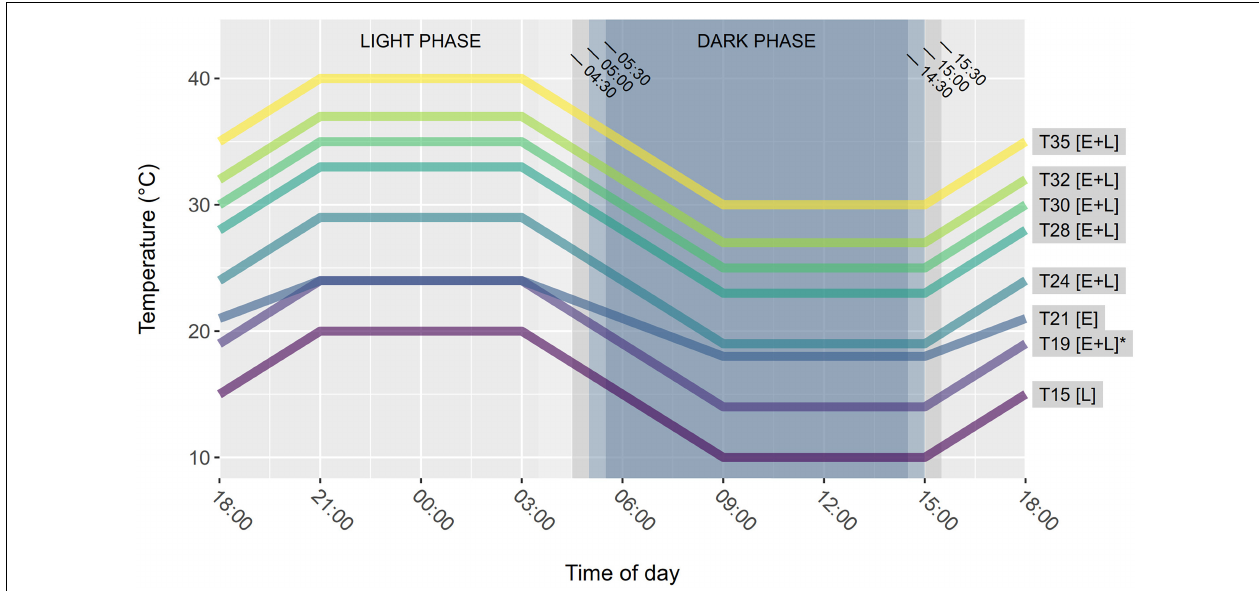
FIGURE 2 | Thermal fluctuations and photoperiod used in each rearing treatment. Transitions between light and dark phases were progressive (30 min with 1/3 of the light source, 30 min with 2/3 of the light source, 9 h with full light). Treatments are named after their average temperature over a 24-h fluctuation cycle. Letters between square brackets indicate whether eggs (E) or larvae (L) were reared in a treatment. T19 is marked with an asterisk because all larvae reared in other treatments originated eggs hatched at T19.